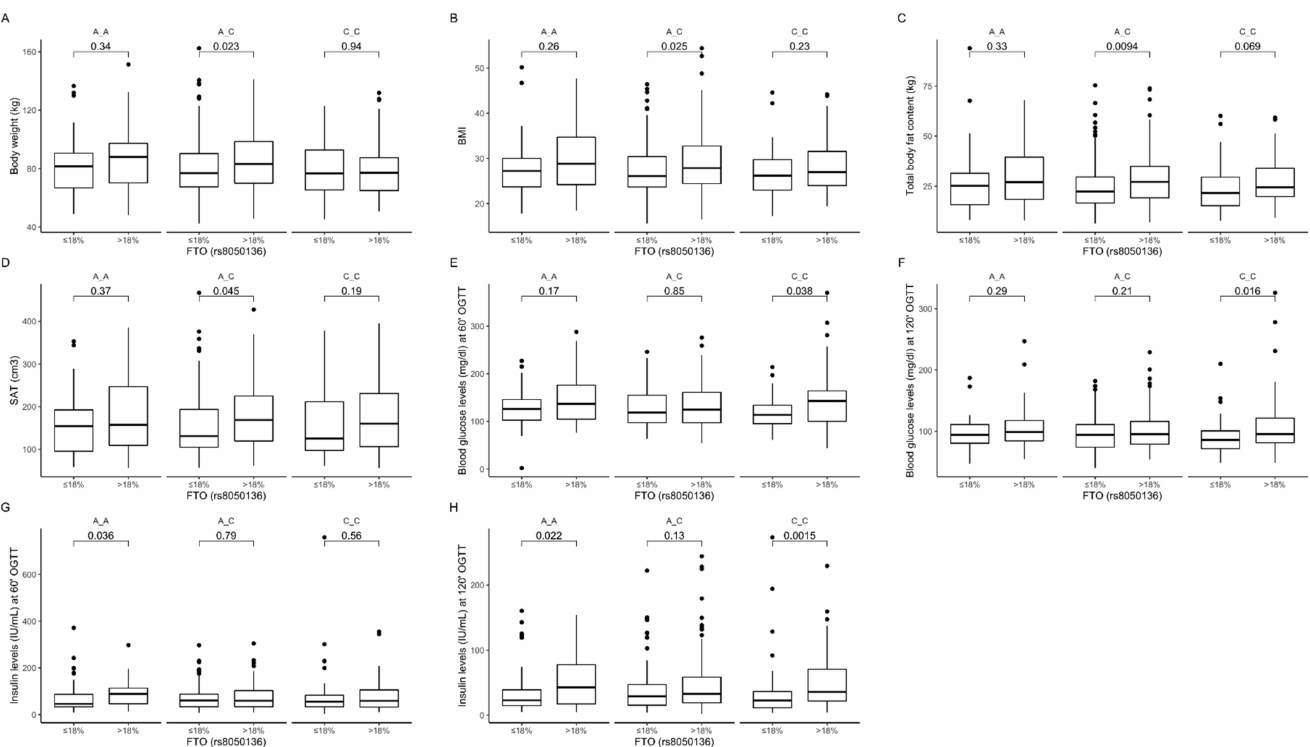
Figure 7. Association of dietary protein intake ≤ 18% and > 18% of total daily energy intake with ( A ) body weight (kg); ( B ) BMI (kg / m 2 ); ( C ) total body fat content (kg); ( D ) SAT (cm 3 ); blood glucose level (mg / dL) at ( E ) 60 min and ( F ) 120 min of OGTT; and insulin level (IU / mL) at ( G ) 60 min and ( H ) 120 min of OGTT in FTO rs8050136 genotype